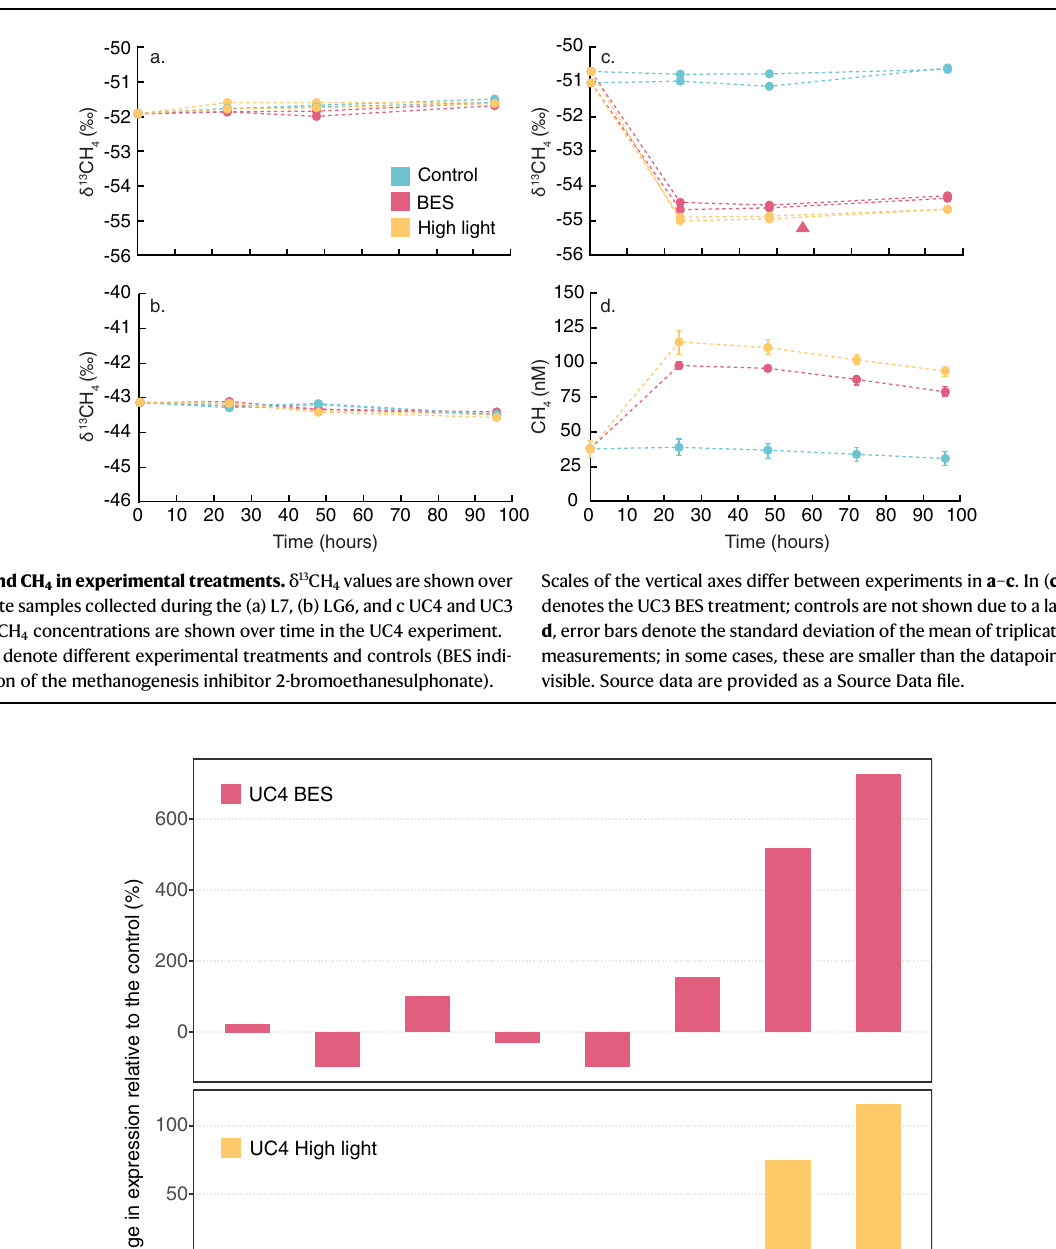
reductase; DPOR and COR) are shown. The BES treatment (addition of the methanogenesisinhibitor2-bromoethanesulphonate)isshowninthetoppaneland thehighlighttreatmentinthebottompanel.Eachpanelshowstheneteffectofthe treatment on the different genes in metatranscriptomes. DNA recombination protein( recA )transcriptsarealsoshownforcomparison.Sourcedataareprovided as a Source Data fi